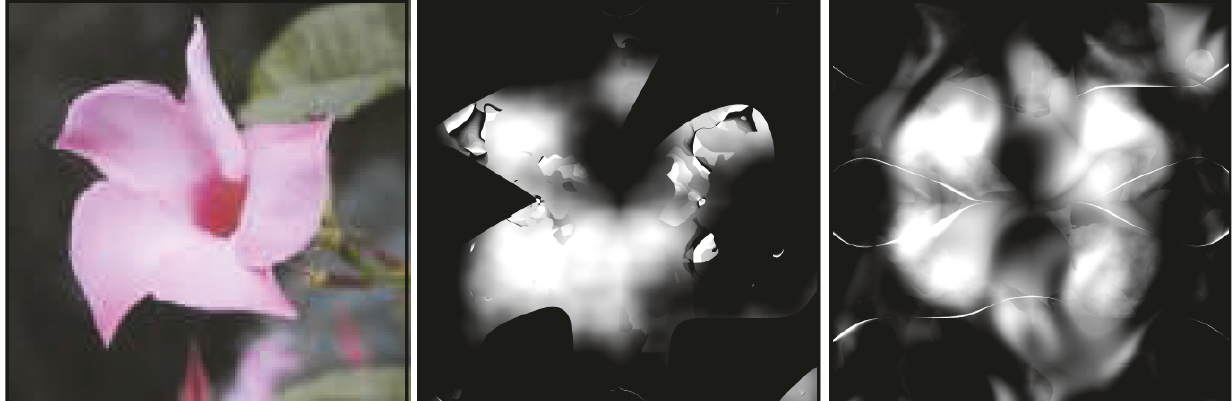
Figure 11: Produced image highlights;noisy language, no 𝑋 ; flower. The leftmost image shows the target, followed by a pair of notable evolved